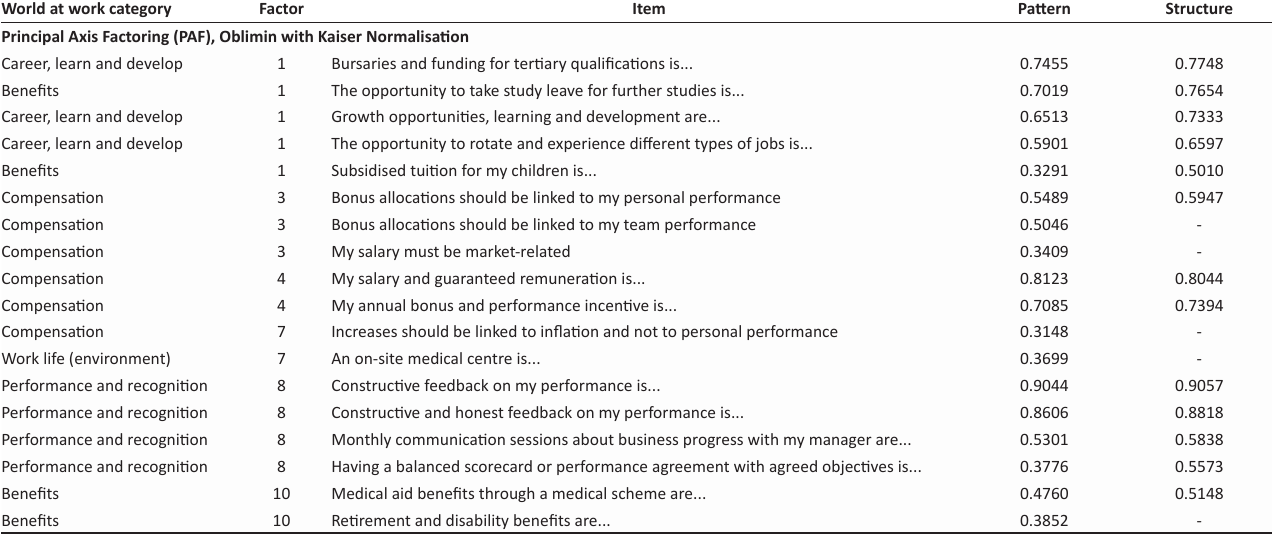
TABLE 5: Six factors identified by Principal Axis Factor, Oblimin with Kaiser normalisation. World at work category